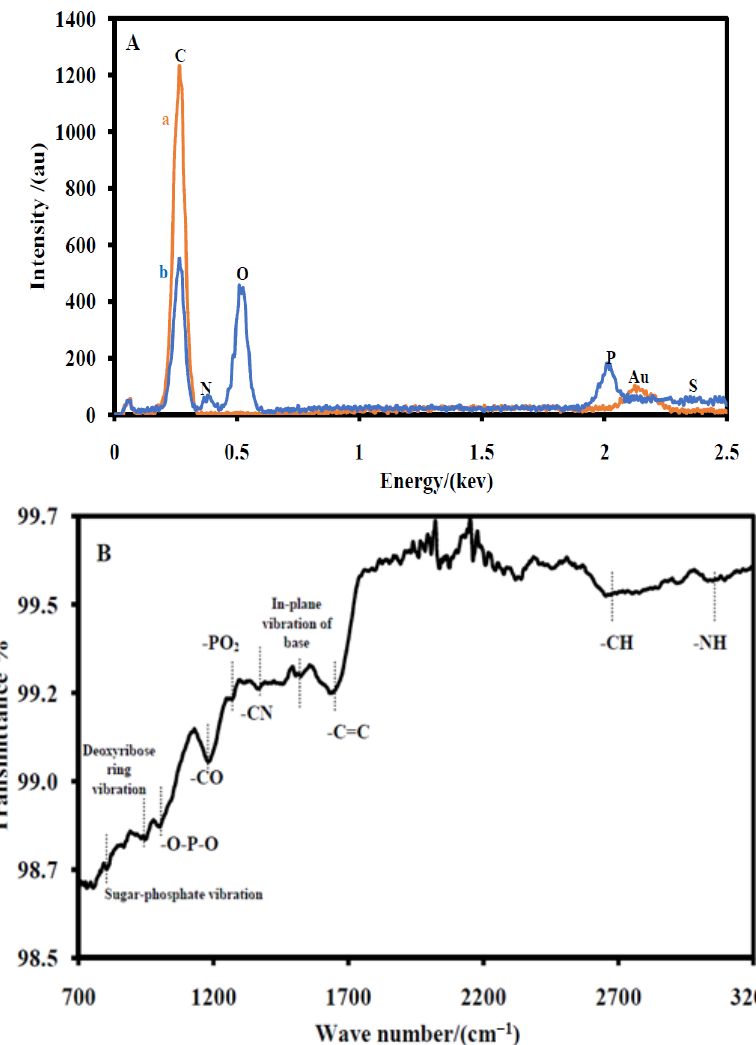
Figure 2. ( A ) EDS of the CSPE/CNFs–AuNPs ( a ) and the CSPE/CNF–AuNP/Aptamer ( b ). ( B ) ATR spectrum of the CSPE/CNF–AuNP/Aptamer.